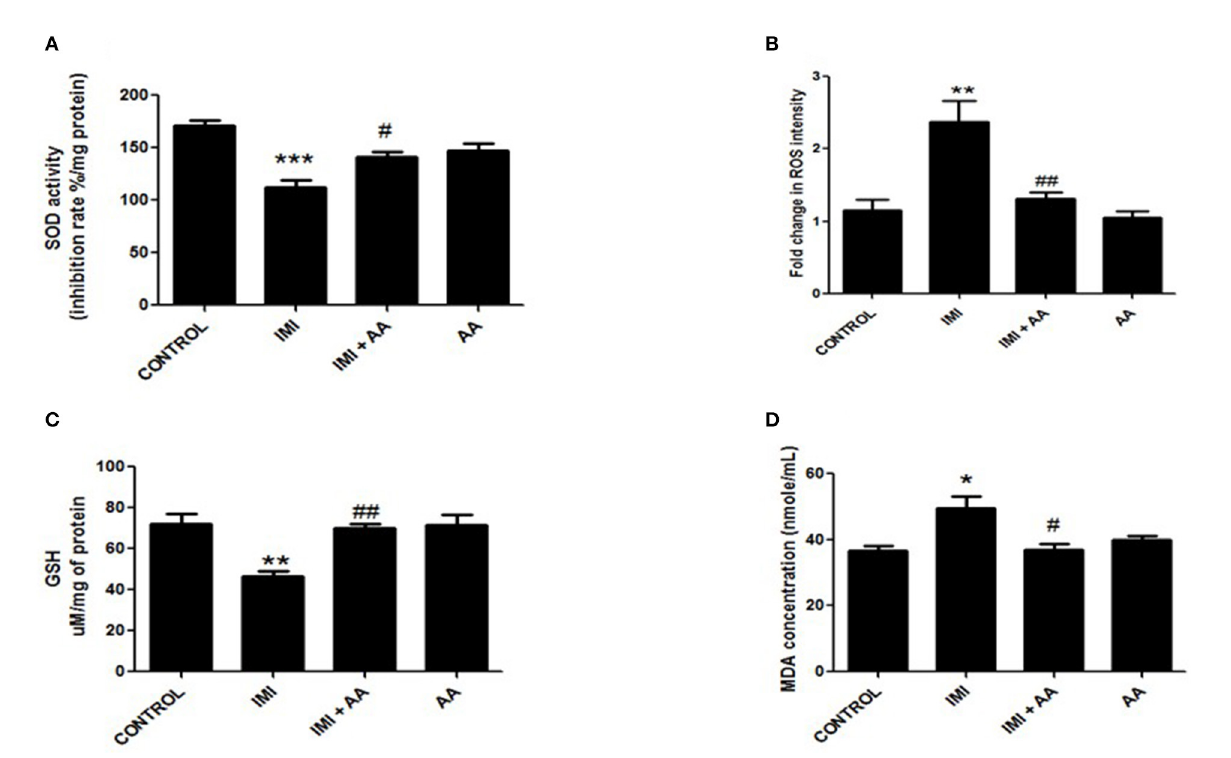
FIGURE4 The effect of Ascorbic acid cm oxidative stress biomarkers. Column figure shows the oxidative stress biomarkers measured in whole brain homogenates of control, IMI, IMI + Ascorbic acid, and Ascorbic acid treated animals. (A) Superoxide Desmutase; (B) Reactive oxygen species intensity; (C) Glutathione activity; (D) Malondialdehyde (MDA) represent mean ± SEM. n = 6 for each group. − Represents significant values when compared to controls at P < 0.05, # represents significant values when compared to IMI-treated animals at P < 0.05, ## represents significant values when compared to IMI-treated animals at P < 0.05. * P ≤ 0.05, ** P ≤ 0.01, *** P ≤ 0.001. These data represent the significant different between treatment and disease control